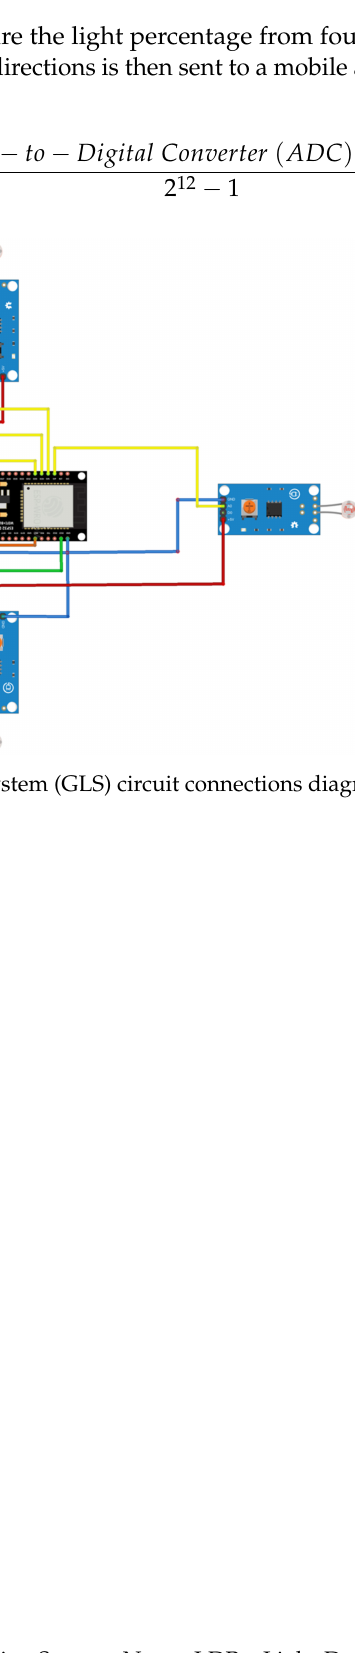
Figure 9. Flowchart of Guidance Landing System. Notes: LDR—Light-Dependent Resistor; V1, V2, V3, V4, and V5 are the virtual pins in the IoT mobile